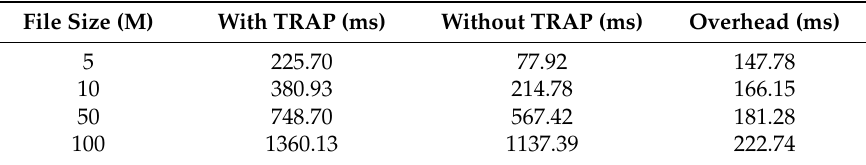
Table 1. Evaluation of